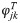
Accuracy of FST and kinship estimators: Overview of models and results.Our analysis is based on the generalized FST definition (section The generalized FST for arbitrary population structures) and two parallel models: the “Coancestry Model” for individual-specific allele frequencies (πij), and the “Kinship Model” for genotypes (xij). The “Coancestry in Terms of Kinship” panel connects kinship (φjkT, fjT) and coancestry (θjkT) parameters (section The kinship and coancestry models). We use these models to study the accuracy of FST and kinship method-of-moment estimators under arbitrary population structures. The “Indep. Subpop. FST Estimator” panel shows the bias resulting from the misapplication of FST estimators for independent subpopulations (F^STindep) to arbitrary structures (section FST estimation based on the independent subpopulations model), as calculated under the coancestry model. The “Existing Kinship Estimator” panel shows the bias in the standard kinship model estimator (φ^jkT,std) and its resulting plug-in FST estimator (F^STstd; section Characterizing a kinship estimator and its relationship to FST), as calculated under the kinship model. The “New Kinship Estimator” panel presents a new statistic Ajk that estimates kinship with a uniform bias, which together with a consistent estimator of its minimum value (A^min) results in our new kinship (φ^jkT,new) and FST (F^STnew) estimators, which are consistent under arbitrary population structure (section A new approach for kinship and FST estimation).